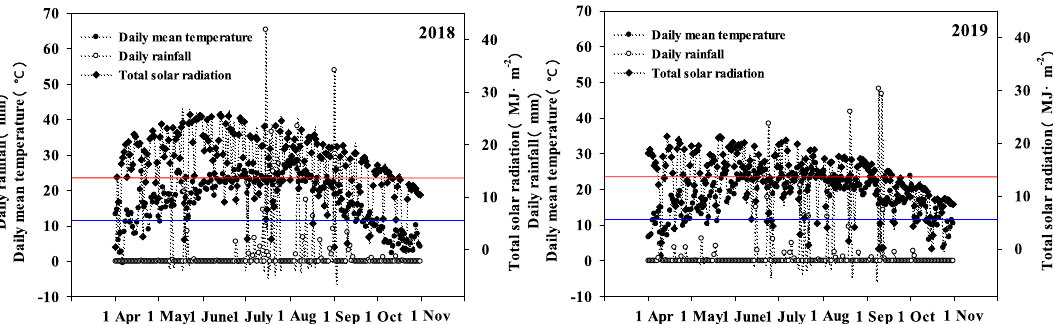
Figure 1. Main meteorological factors during the growth period in the experimental area.